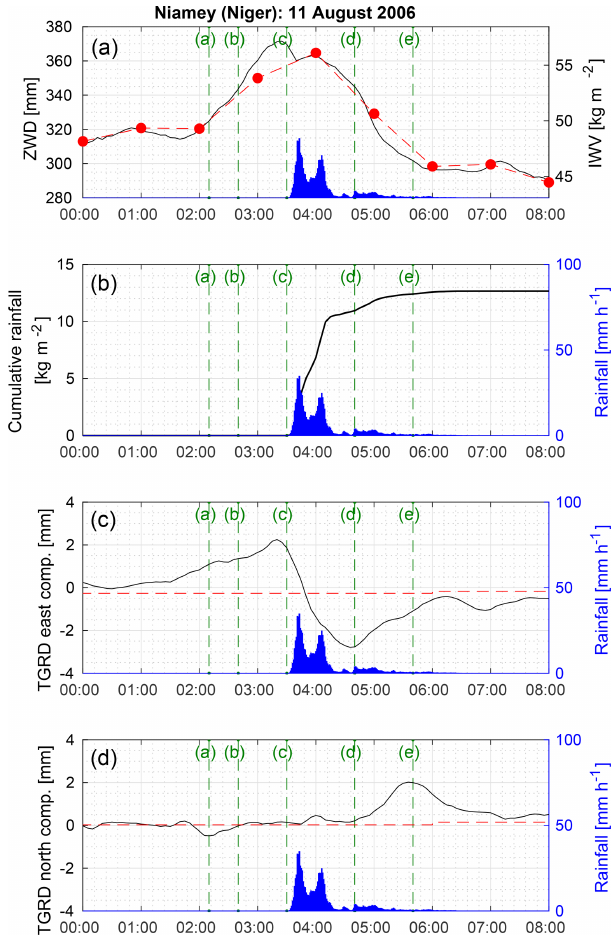
Figure 8. Tropospheric estimates from the GIPSY-OASIS (black solid line) and GAMIT (red dashed line) software packages during the MCS event on 11 August 2016 at Niamey, Niger: (a) zenithal wet delay (mm) and its equivalent IWV (kgm − 2 ; red dots), (c) east component of the tropospheric gradients, and (d) north compo- nents of the tropospheric gradients (mm). (b) The cumulative rain- fall (kgm − 2 ; black line) is computed from the 1min retrieved rainfall (mmh − 1 ; blue bar plots) from the ARM Mobile Facil- ity. Rainfall (mmh − 1 ; blue bar plots) in panel (a) is repeated from (b) – (d) but is not displayed with a dedicated graduation axis. The times of the reflectivity maps given in Fig. 6 are shown us- ing vertical dashed green lines and correspond to (a) 02:10UTC, (b) 02:40UTC, (c) 03:30UTC, (d) 04:40UTC, and (e)